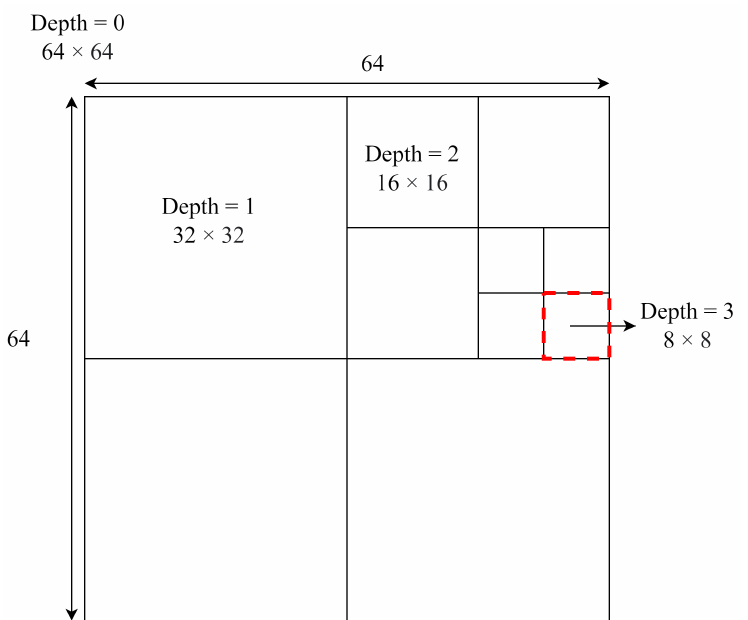
Figure 1. Example of CTU partition.